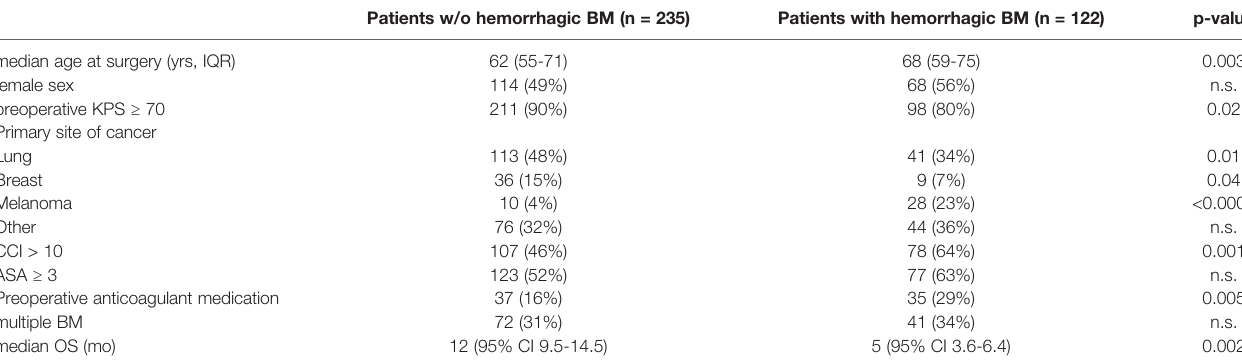
TABLE 2 | Characteristics of hemorrhagic brain